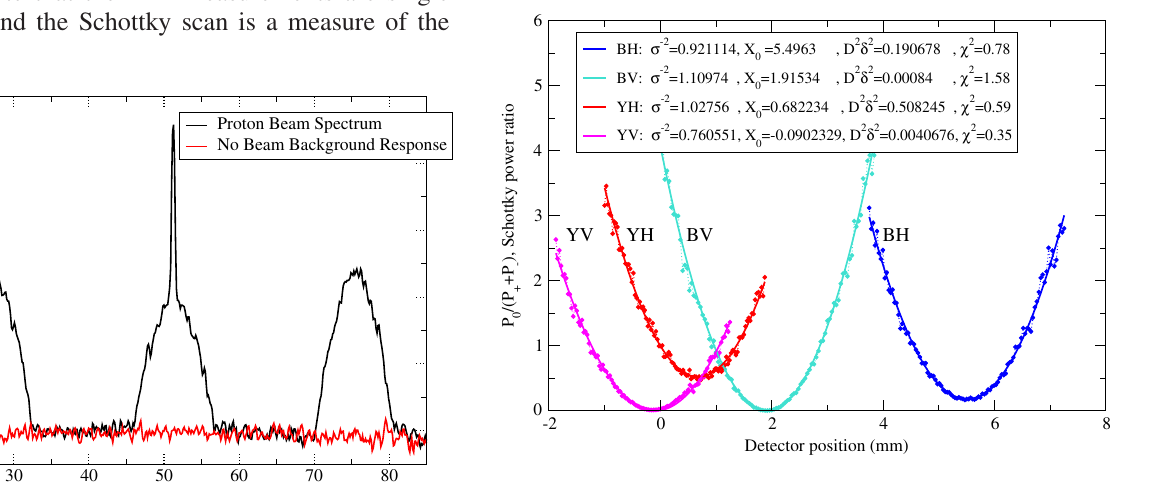
FIG. 5. (Color) Data and fitting results from studies performed during this year’s polarized proton run. BH, BV, YH, and YV denote blue ring horizontal, blue ring vertical, yellow ring horizontal, and yellow ring vertical, respectively.